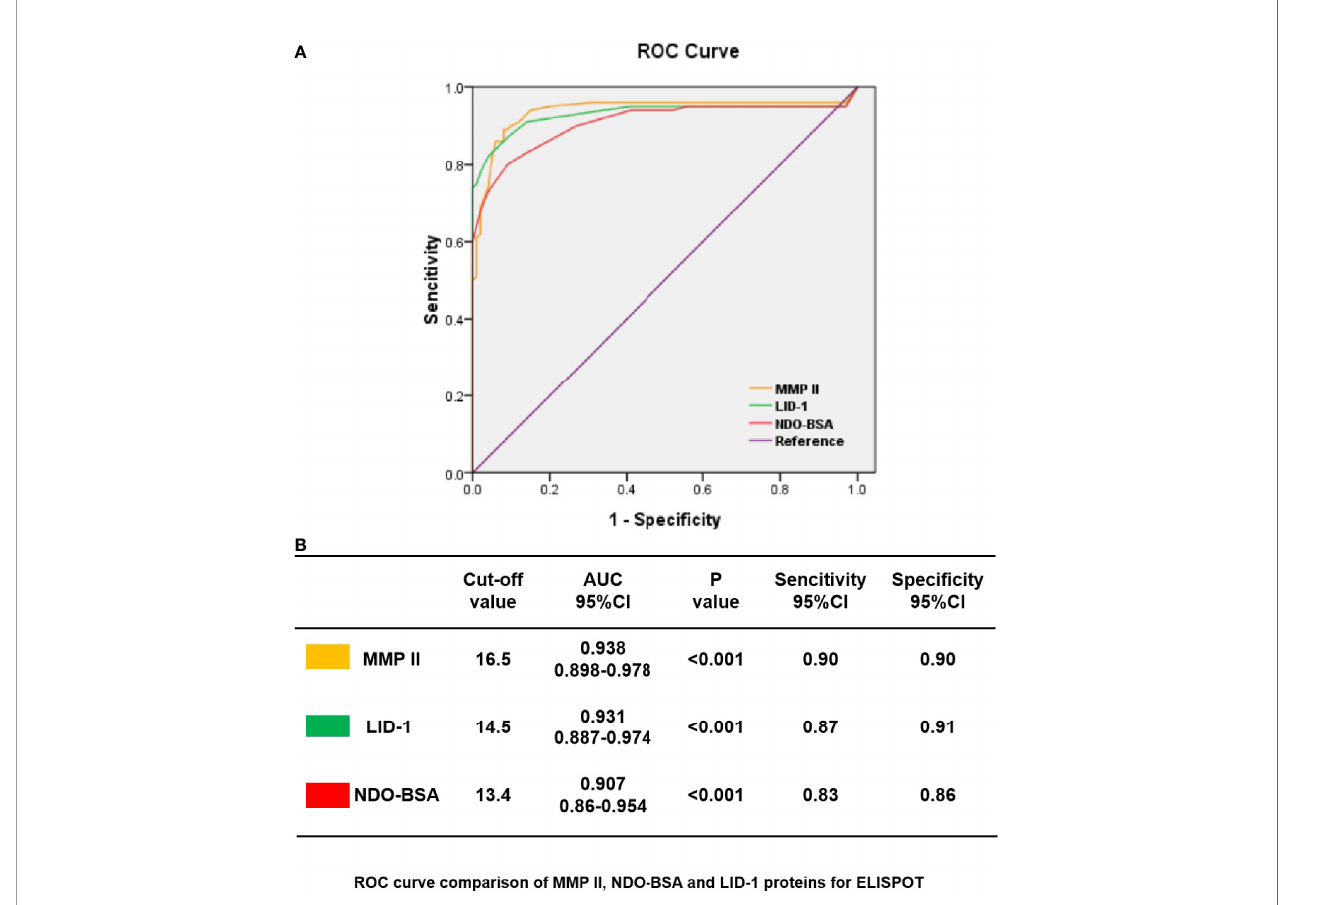
FIGURE 2 | ROC curves showing the accuracy of host marker IFN- g in discriminating among PB, MB, HHC, and HD. ROC curves for the accuracy of single markers IFN- g induced by MMP II, NDO-BSA, and LID-1 to differentiate among PB patients and other controls (A) . ROC curves for markers that differentiated PB patients with health controls with p<0.001 are shown; the cutoff values with MMP II, NDO-BSA and LID-1 were 16.5, 13.4, and 14.5 respectively (B) .